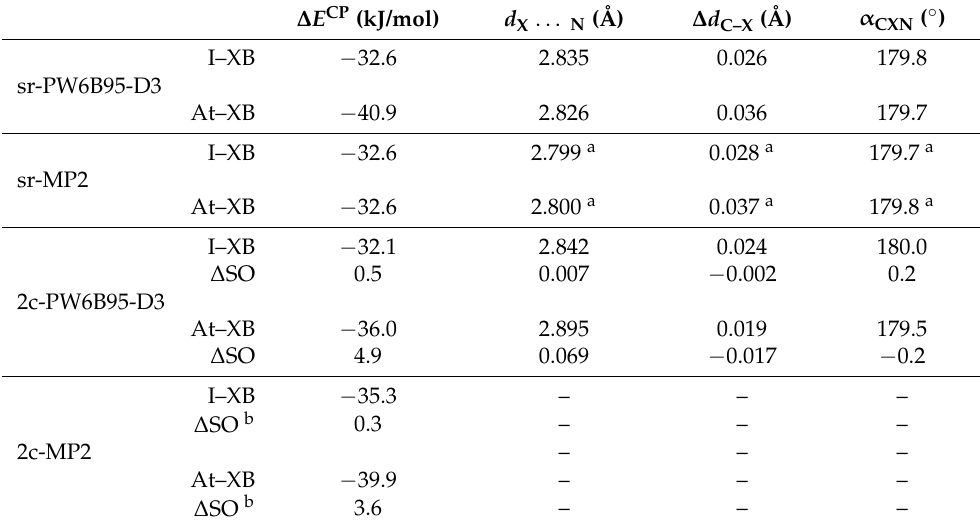
Table 3. PW6B95-D3/TZVPPD and MP2/TZVPPD counterpoise corrected interaction